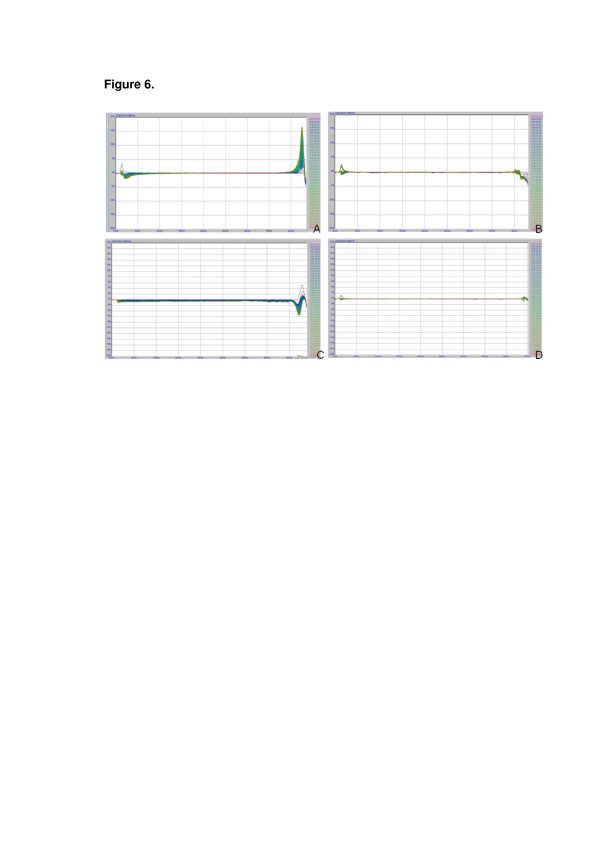
Backscattering profiles of formulations. (a) NC, (b) G-NC, (c) G-NC-M, and (d) G-NC-L.